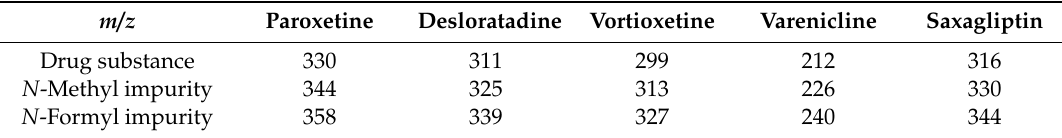
Table 1. Compounds’ m / z used for selected ion monitoring (SIM) acquisitions using electrospray ionization in positive mode (( + )ESI-MS).